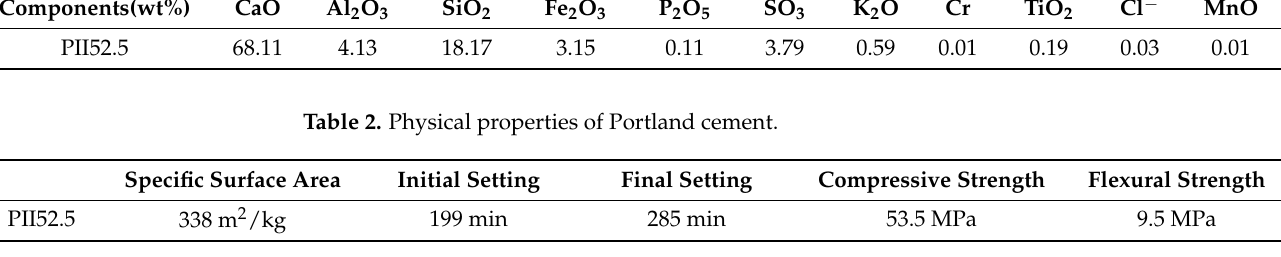
Table 1. Chemical composition of Portland cement.